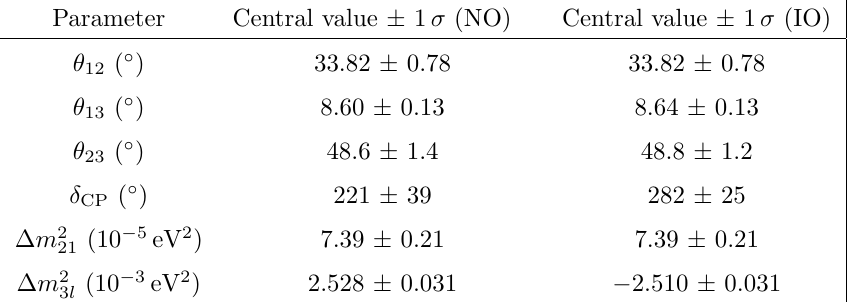
Table 2. The current best-(cid:12)t values and 1 (cid:27) uncertainties for the neutrino oscillation parameters [6]. These values are shown for both mass orderings and are taken from a recent global analysis.